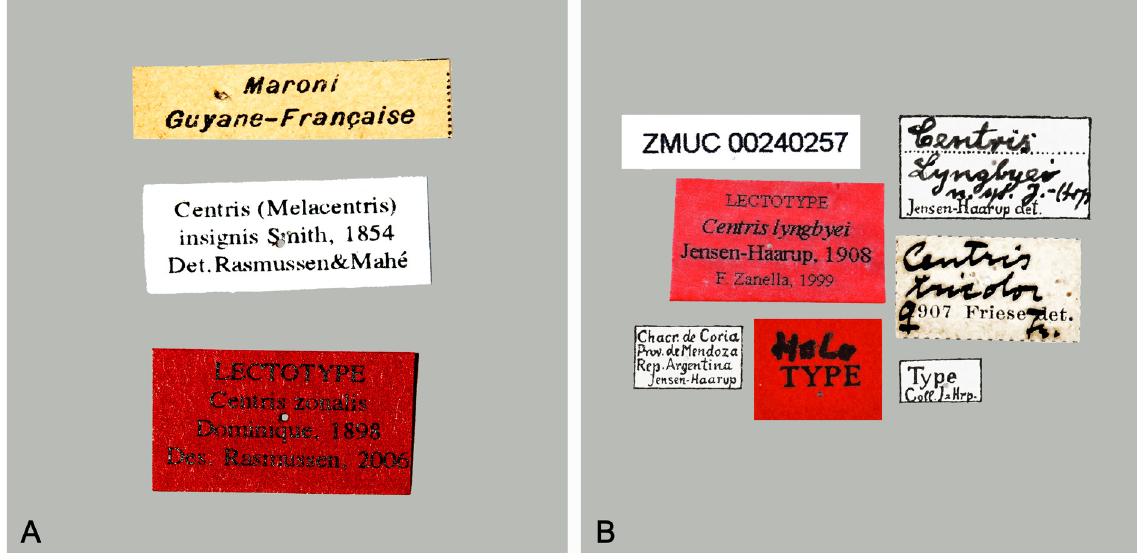
Fig 2. Data labels. A . Centris zonalis Dominique, 1898 (lectotype ♀︎). B . Centris lyngbyei Jensen- Haarup, 1908 (lectotype